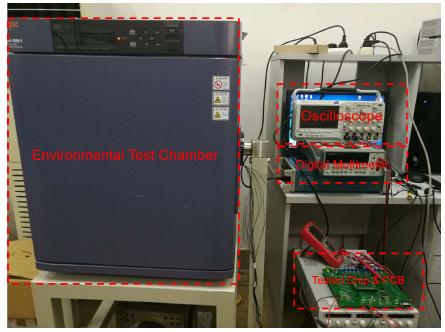
Figure 7. Experimental setup for testing the charge